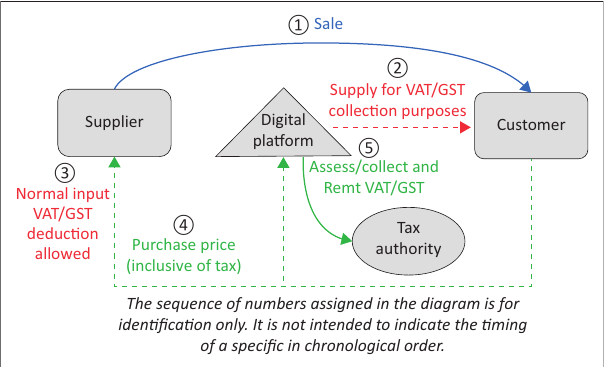
FIGURE 2: Use of digital